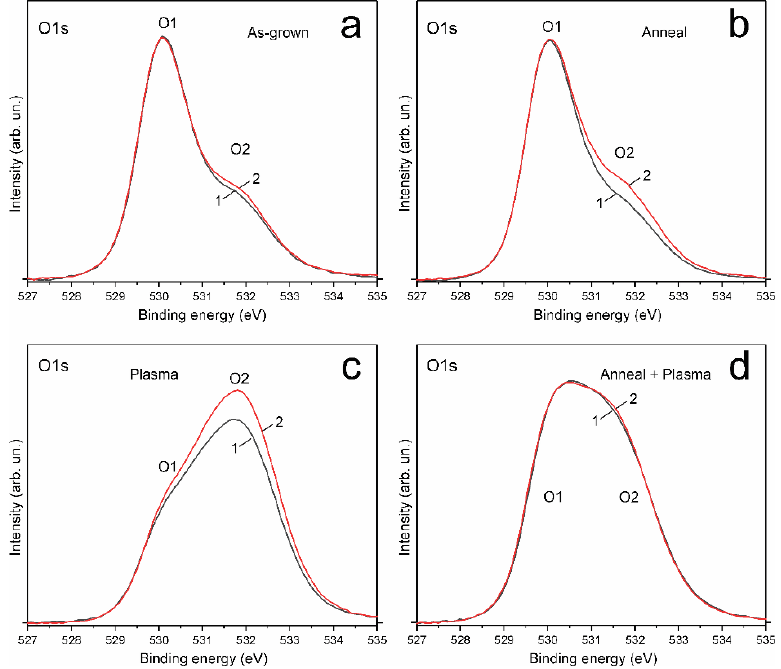
Figure 6. XPS O1s spectra of the ZnO samples measured 6 days (1) and 76 days (2) after plasma treatment: ( a ) AG sample, ( b ) A-sample, ( c ) P-sample, ( d ) A + P sample.